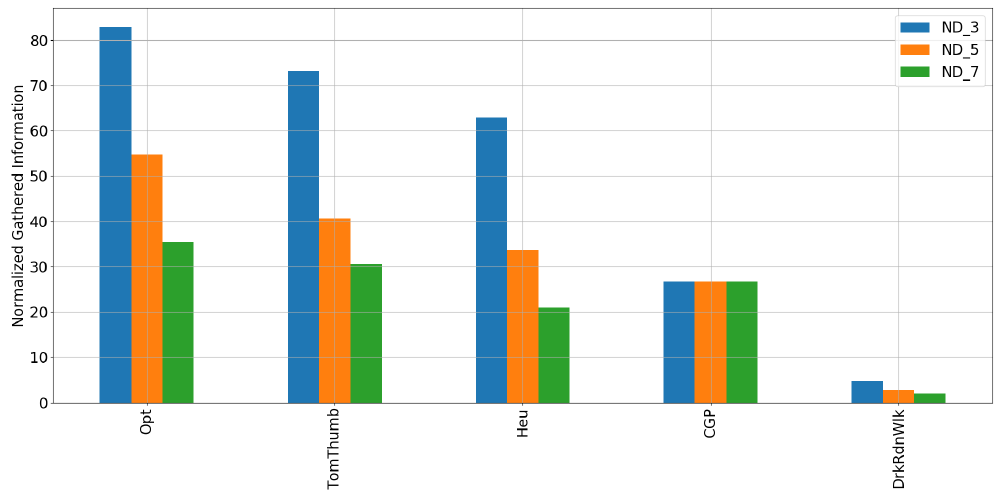
Figure 7. Normalised gathered information comparisons among the proposed TT and alternative approaches for Scenario 1 and different ND values.